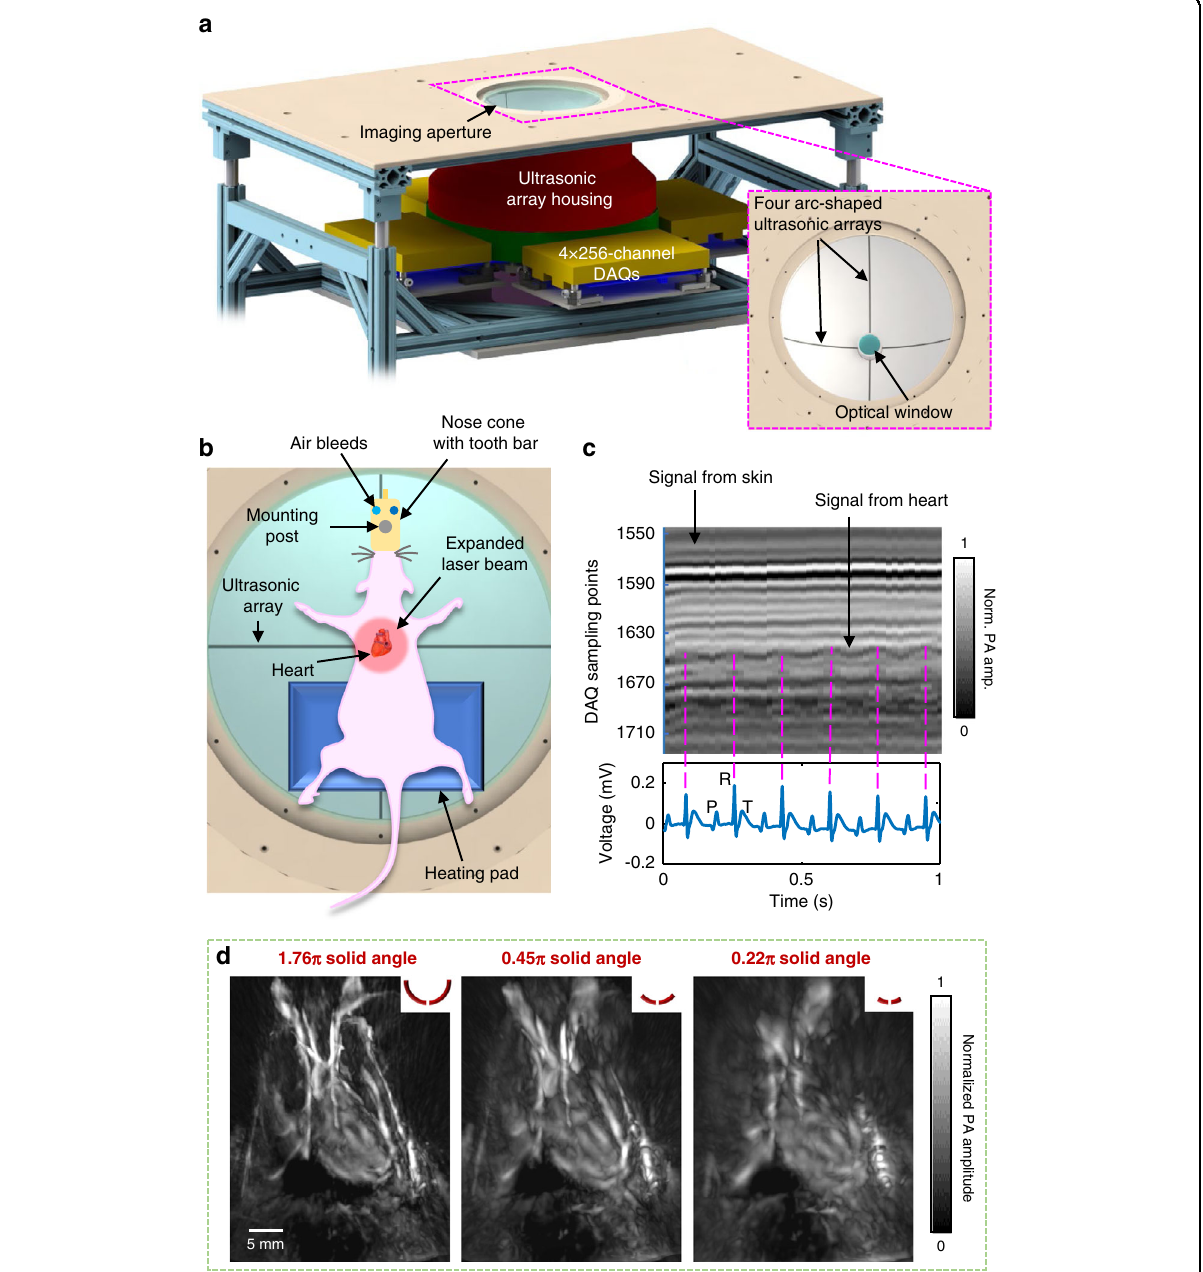
Fig. 1 3D-PACT synchronized with ECG for cardiac imaging. a Representative sketch of the 3D-PACT platform with a close-up view of the imaging aperture. b Experimental setup for the rat heart imaging. The rat was mounted in a prone position, and the expanded light beam was directed towards the rat ’ s chest from the bottom. c Example of the signal synchronization between the 3D-PACT (top) and ECG (bottom) measurements. The 3D-PACT signal was collected from one transducer element on one array at multiple scanning positions (i.e., on the same latitude). In the photoacoustic signal diagram, the horizontal axis represents the scanning steps (i.e., time), and the vertical axis stands for the time-of- fl ight signal (data acquisition sampling at 20 MHz). The P, R, and T waves in the ECG signals correspond to atrial contraction, ventricular contraction, and ventricular relaxation, respectively. d The rat heart images reconstructed with different ultrasonic apertures, showing the impact of a sizeable ultrasonic detection aperture on image reconstruction. The red arcs on the top right corner of each image represent the cross-sectional view of